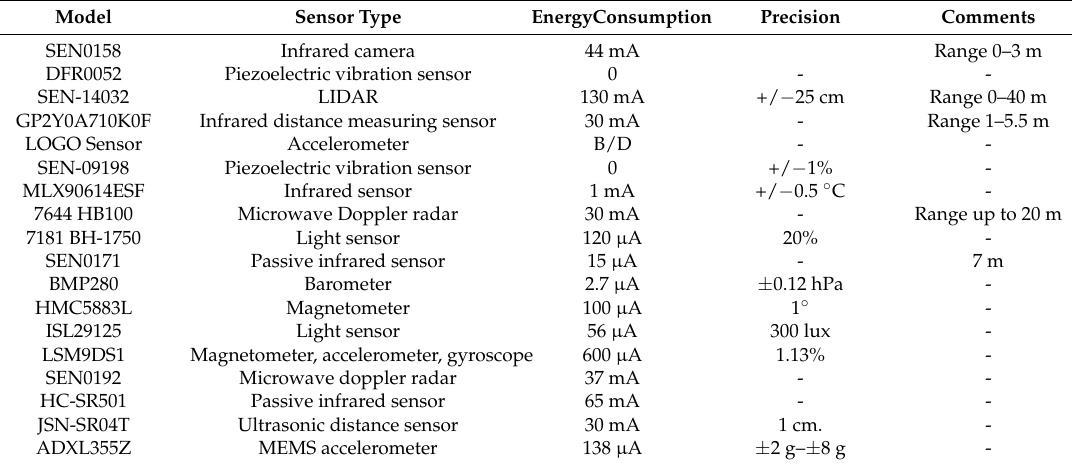
Figure 4. Housing of light sensor: (1) hole with diameter 3 mm, (2) sensor ISL2915. Table 5. Sensors installed in